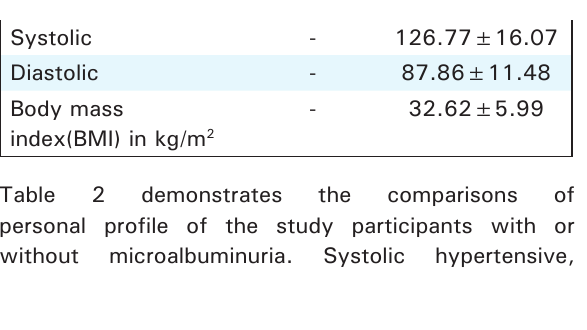
Table 2. Comparison of the study participants with and without microalbuminuria among different study variables.